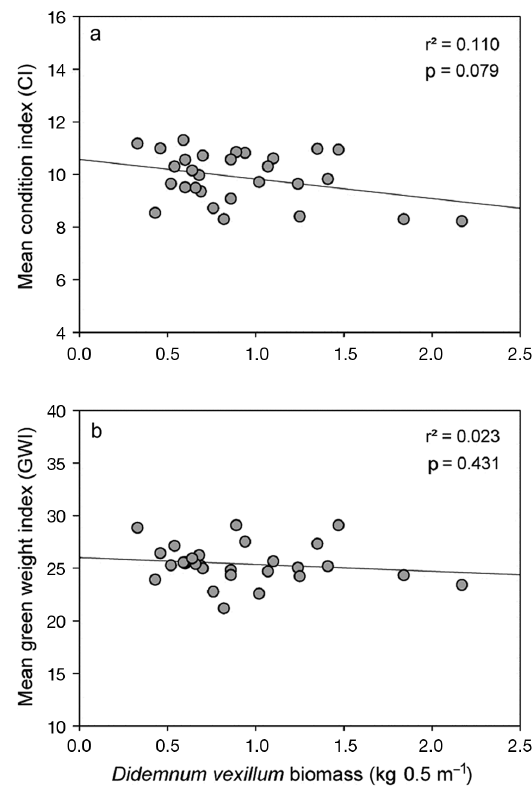
Fig. 8. Perna canaliculus and Didemnum vexillum . Relation- ship between (a) mean mussel condition index (CI) and (b) mean mussel green weight index (GWI) per 0.5 m section of mussel line and D. vexillum biomass present for each sec- tion. Results are pooled across mussel size classes (n = 29